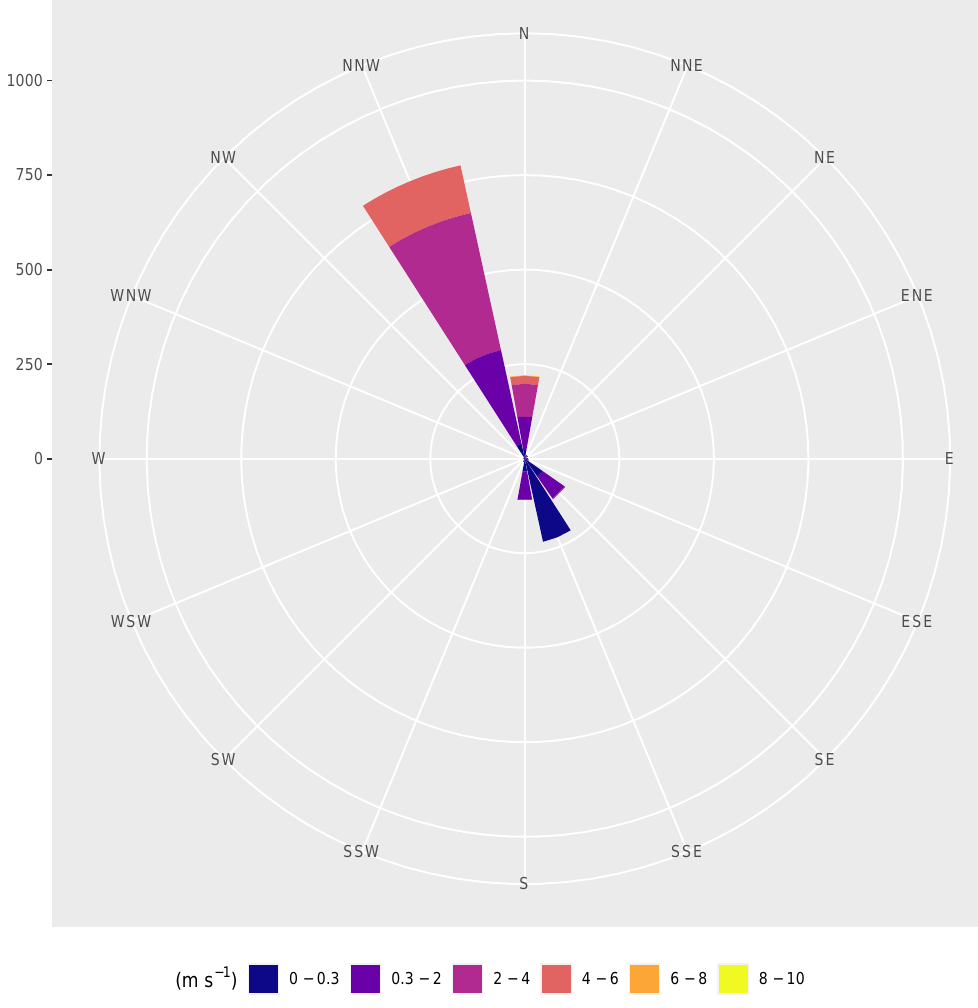
Figure 6. Wind rose of hourly wind speeds during the VWD at the NE bottom